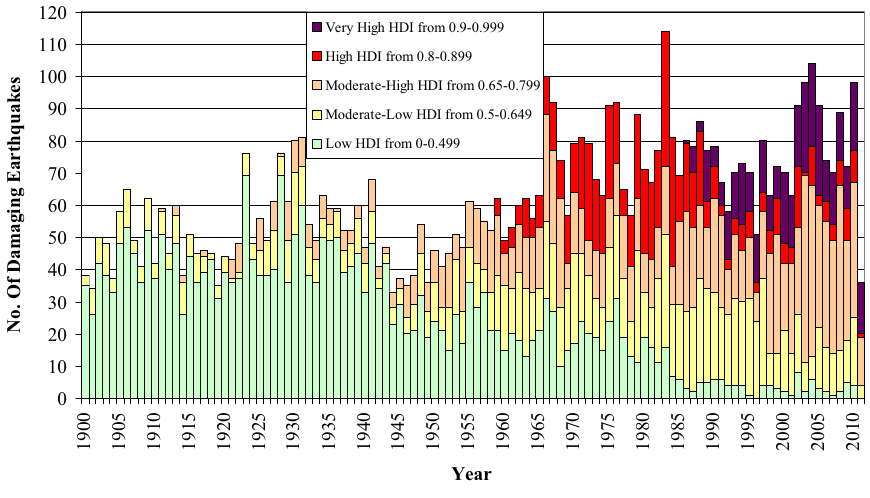
Fig. 3. Damaging earthquakes in the CATDAT damaging earthquakes database from 1900–2011 (up to April, 2011).